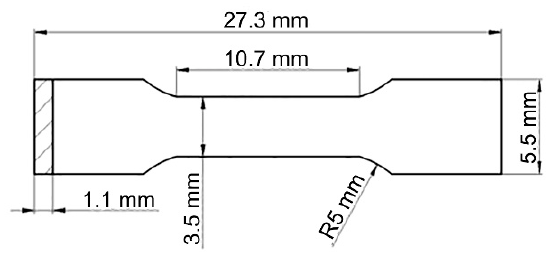
Figure 1. Shape of the tensile samples.